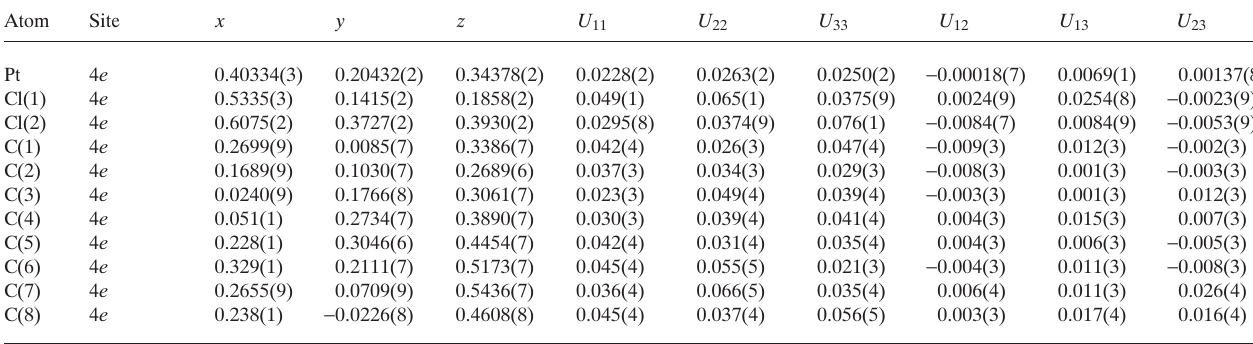
Table 3. Atomic coordinates and displacement parameters (in Å 2 ) .